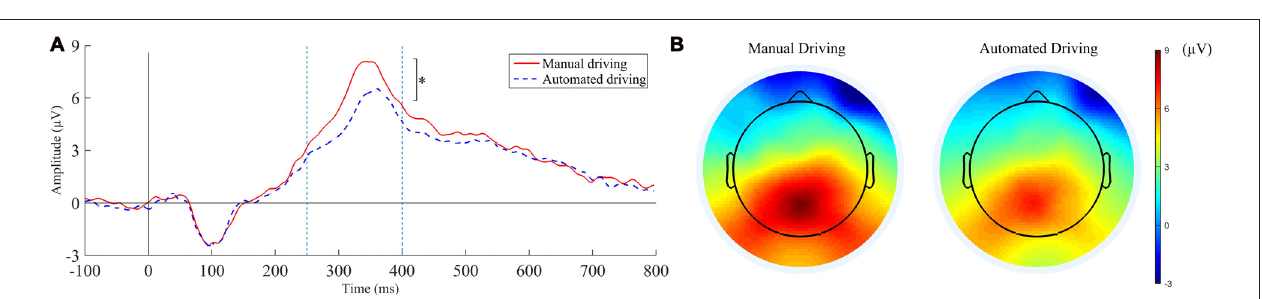
Frontiers in Human Neuroscience |